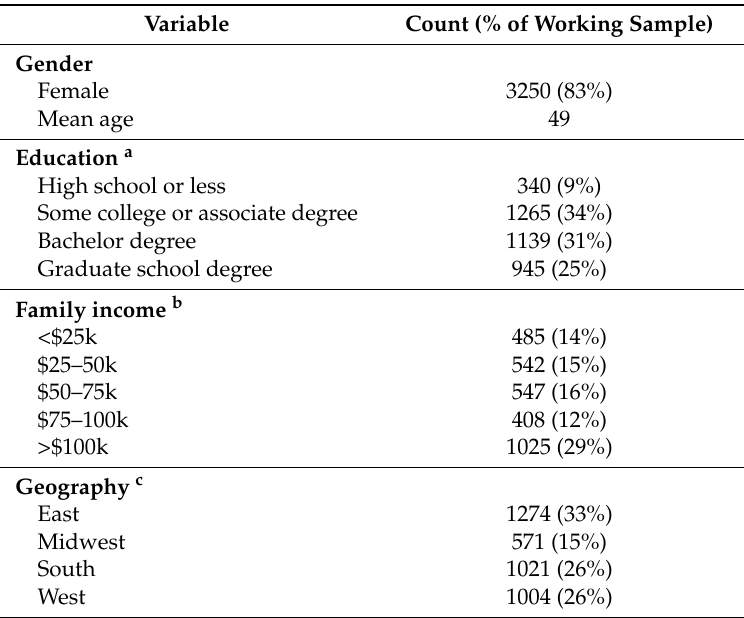
Table 1. Demographic characteristics of respondents.